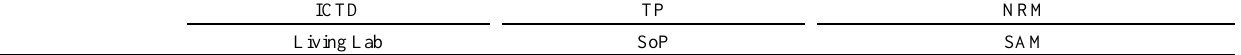
Table 2 . Some attributes of complex systems in terms of adaptive solutions. ICTD TP NRM Living Lab SoP